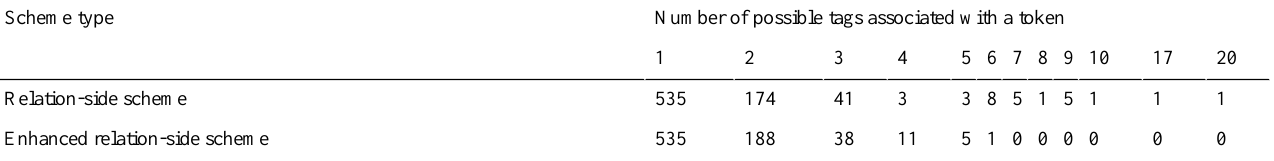
Table 5. Comparison of the degrees of ambiguity between the relation-side scheme and enhanced relation-side scheme. Note that the tokens that were only associated with the “O” tag were excluded.